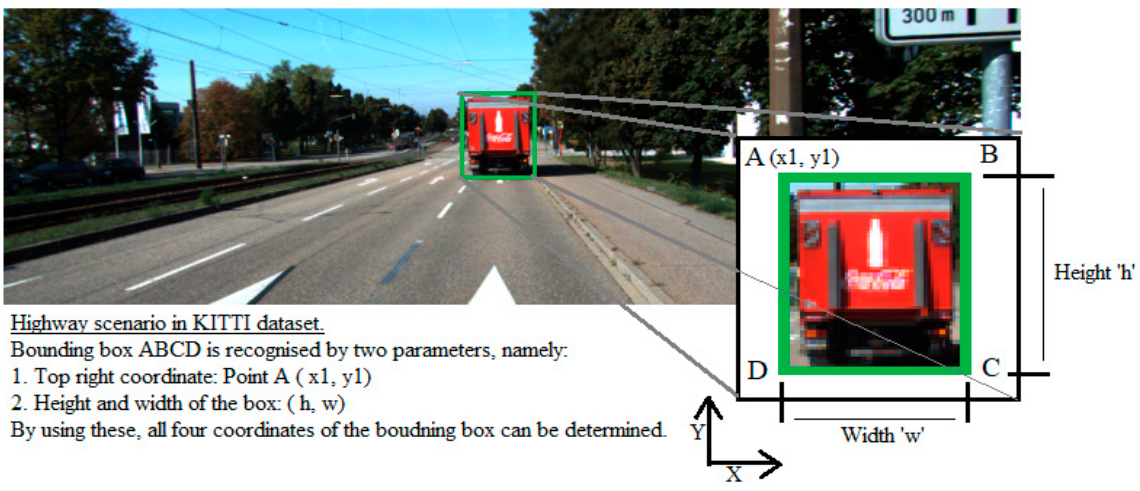
Figure 10. Description of a bounding box for a detected object in 2D space.